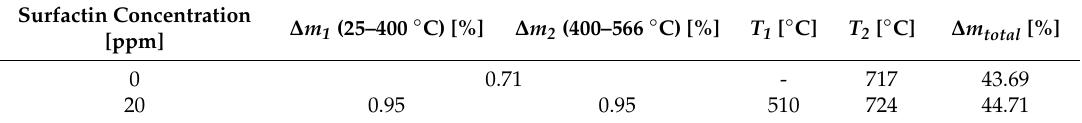
Figure 4. TG and DTG curves of the calcium carbonate structures obtained without and with 20 ppm of biosurfactant. Time of reaction was 24 h. The concentration of CaCl 2 and Na 2 CO 3 was 5 mM. ( A ) TG; ( B ) DTG. Table 4. Thermogravimetry results of the samples ( ∆ m –weight loss, T –maximum on the DTG curve, onset-temperature- of main degradation start).